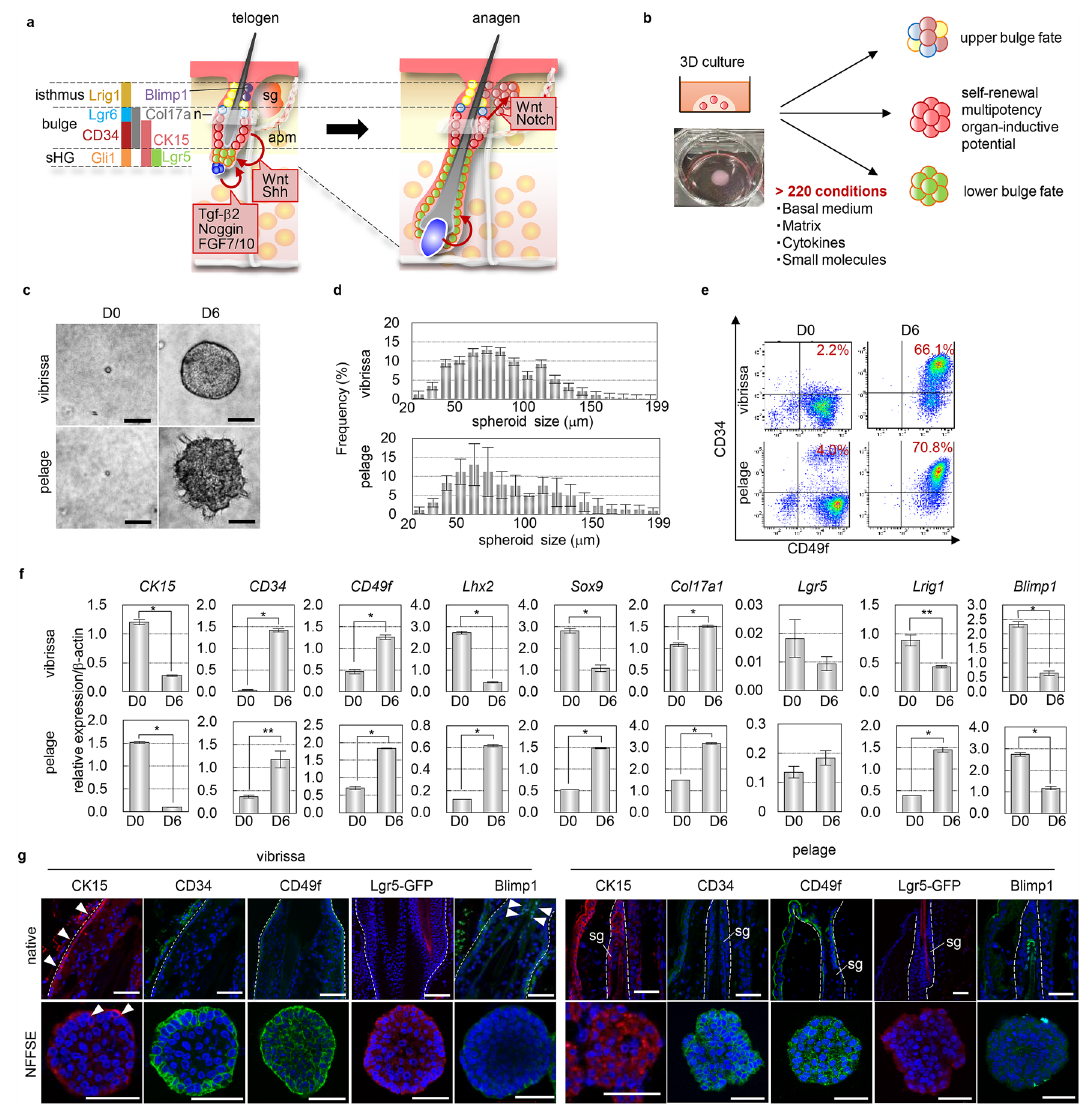
Figure 1. Identification of culture conditions that can control the status of HFCSs. ( a ) Schematic illustration of reported HFSCs in mouse pelage HF and signaling pathways contributing to HFCS maintenance and activation. ( b ) Experimental scheme of the 3D cell culture for HF bulge epithelial cells. Epithelial cells were isolated by micro dissection and subsequent enzyme treatment from the bulge of adult mouse vibrissa at the growing phase, anagen, or back skin at the resting phase, telogen, including pelage HFs. ( c ) Phase contrast images of cultured cells isolated from adult mouse vibrissa (upper panels) or pelage HF (lower panels) at the indicated time point in 3D culture. ( d ) Quantification analysis of the size of spheroids cultured in NFFSE medium. Frequency was calculated from 1,000 spheroids ( e ) Replicative FACS plot for indicated markers on freshly isolated and cultured epidermal cells. ( f ) Replicative qPCR analysis of indicated markers on freshly isolated or cultured cells. ( g ) Representative immunofluorescence of the indicated markers on native vibrissa HFs, pelage HFs, and cultured spheroids of C57BL/6 or Lgr5-EGFP mice. Dashed lines indicate the border between the epithelium and dermis. sg, sebaceous gland. Data are presented as the mean ± SD. *p < 0.001; **p < 0.002. Scale bars, 20 μm. See also Supplemental Fig.